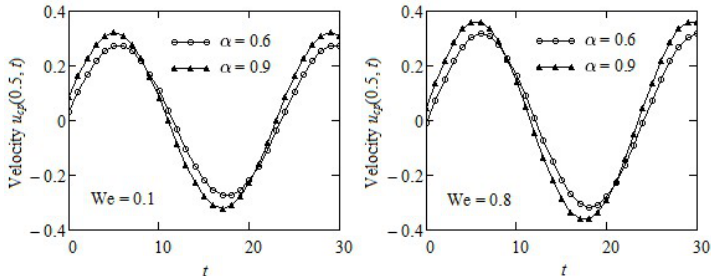
Figure 5. Profiles of velocities u cp ( 0.5, t ) for Re = 100, ω = π /12, α = 0.6 and α = 0.9 and two values of Weissenberg number